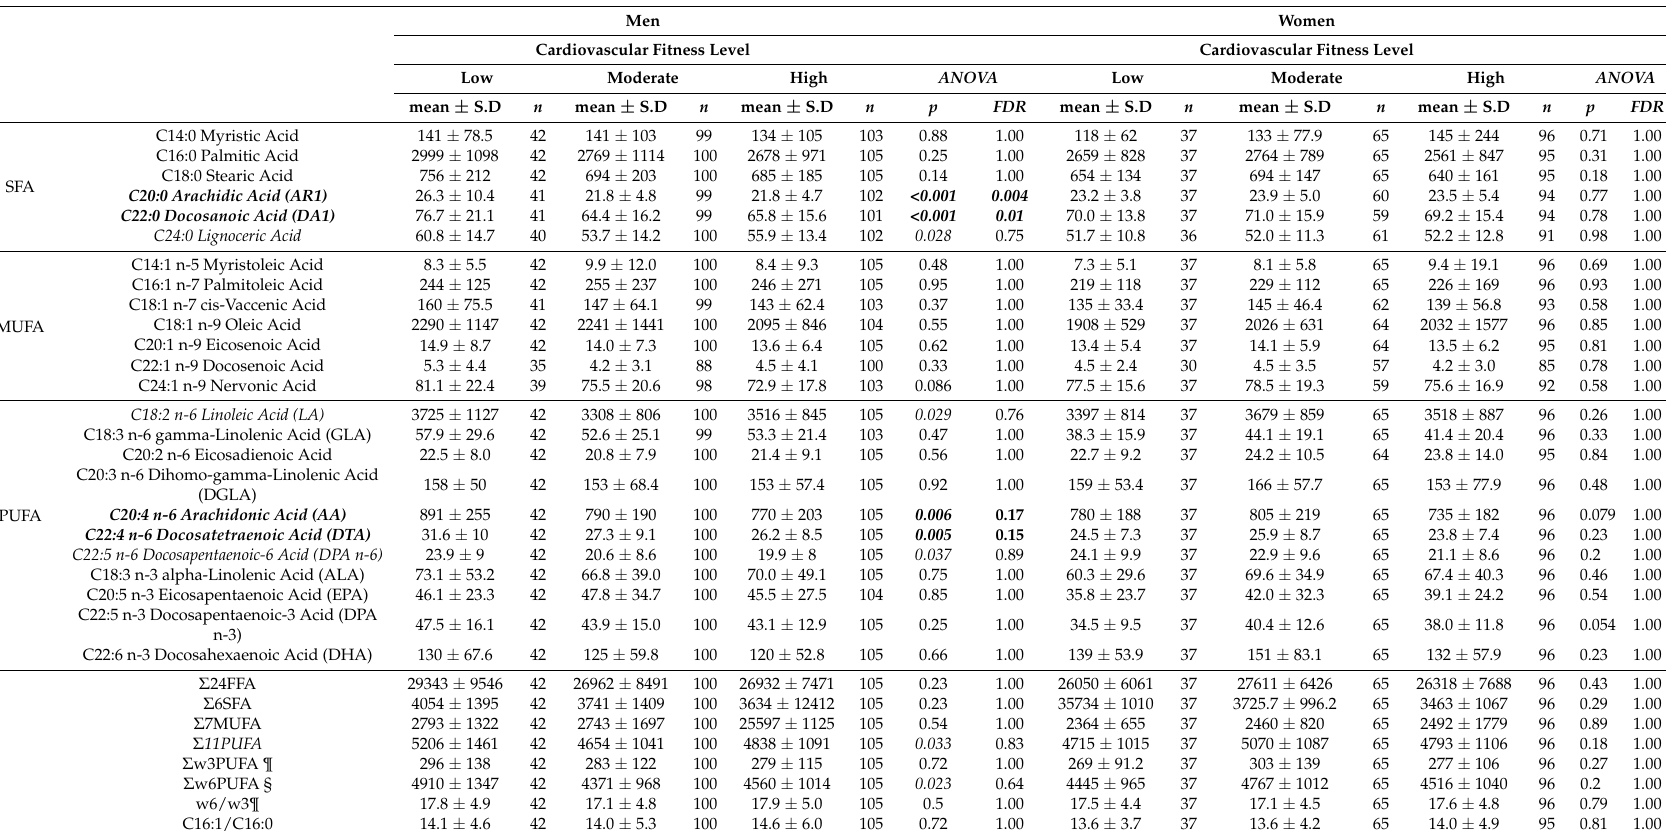
Table 3. Twenty-four Fatty Acid Levels in Fasting Plasma and 8 derivative variables of interest among 3 cardiovascular levels further stratified by